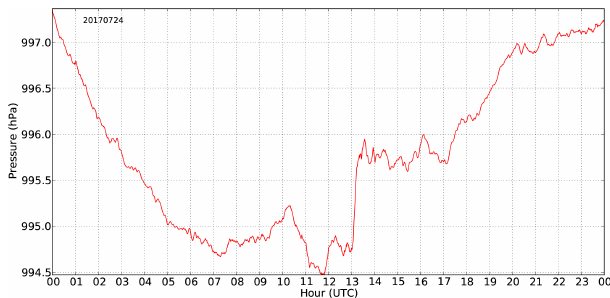
Figure 3. Time series for 24 July 2017 00:00–24:00UTC: ground atmospheric pressure